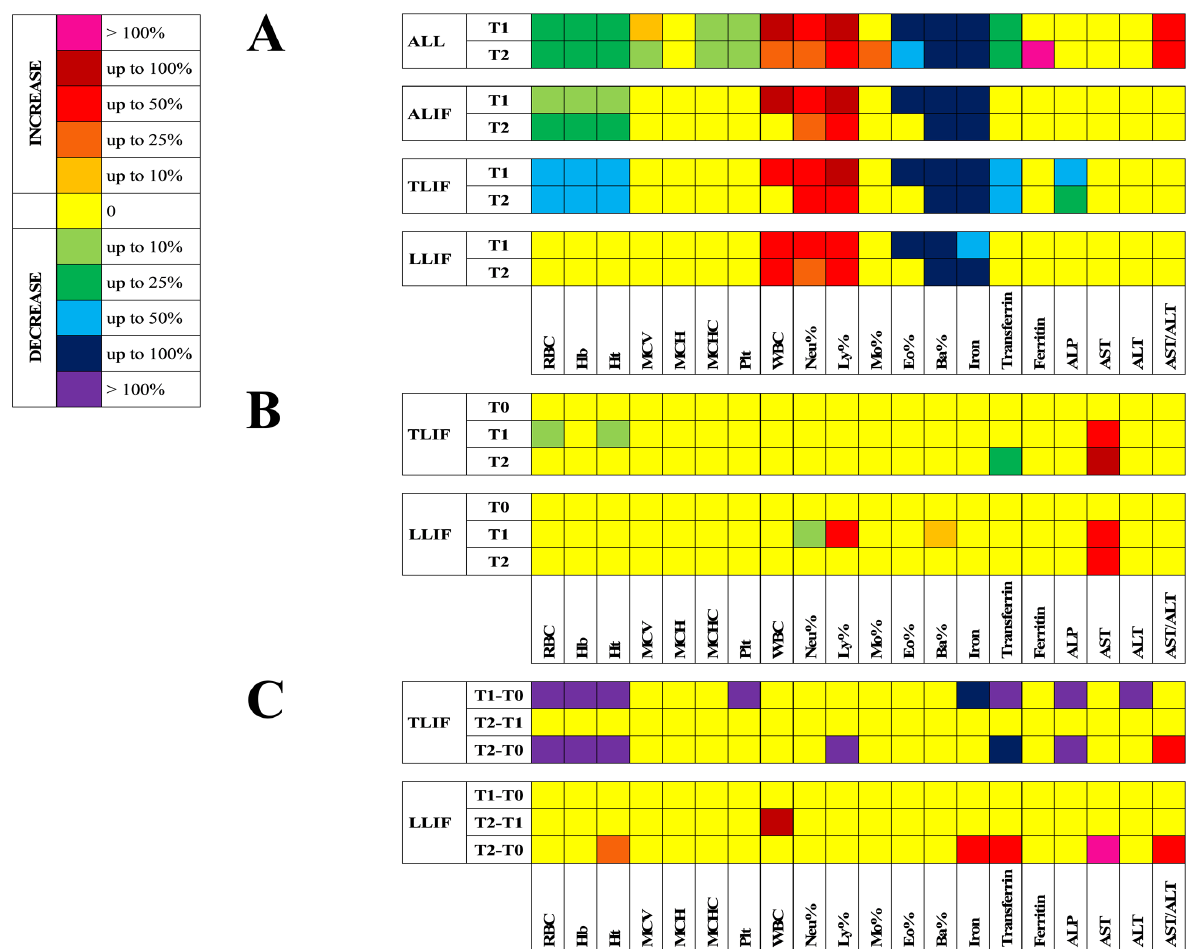
Figure 1. Hematological parameters and clinical chemistry profile. ( A ) Comparison of the hematological and clinical chemistry profiles with the relative baseline value (T0) in the whole cohort (ALL), and in the three approaches (ALIF, TLIF, and LLIF). ( B ) Comparison of the hematological and clinical chemistry profiles with ALIF, at each time-point. ( C ) Comparison of the amplitude of changes, between the different time-points (T1–T0, T2–T1, T2–T0) of the hematological and clinical chemistry profiles with those of ALIF. The color scale indicates the degree of percentage variation. ALIF: Anterior Lumbar Interbody Fusion; TLIF: Transforaminal Lumbar Interbody Fusion; LLIF: Lateral Lumbar Interbody Fusion; RBC: red blood cells; Hb: hemoglobin; Ht: hematocrit; MCV: mean corpuscular volume; MCH: mean hemoglobin content; MCHC: mean corpuscular hemoglobin content; Plt: platelet count; WBC: white blood cells; Neu: neutrophils; Ly: lymphocytes; Mo: monocytes; Eo: eosinophils; Ba: basophils; ALP: alkaline phosphatase; AST: aspartate aminotransferase; ALT: alanine aminotransferase.